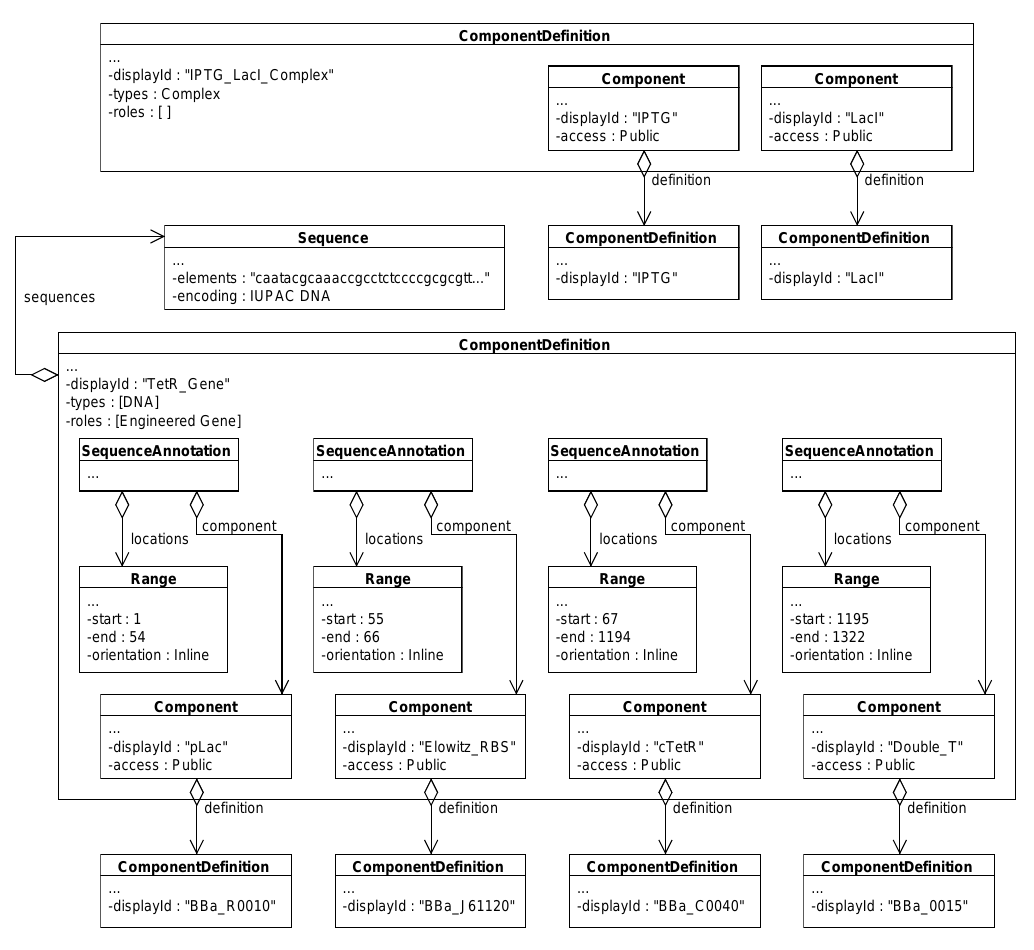
Figure 26: Composite ComponentDefinition objects for the LacI inverter. In the case of the ComponentDefinition that represents the TetR gene, its sub- Component objects are located as Range s along its Sequence using SequenceAnnotation objects. The ComponentDefinition that represents the IPTG-LacI complex, however, has no Sequence and its sub- Component objects are composed without any data about their relative positions.